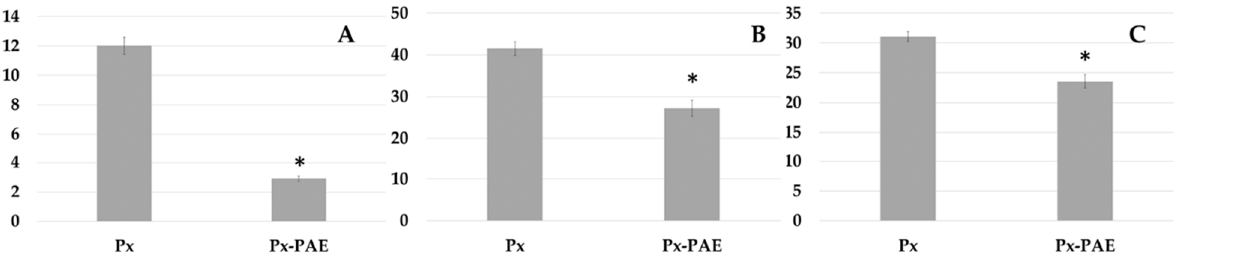
Figure 9. Control of P. xanthii by spraying zucchini plants with P. variotii . ( A ). Mean proportion of leaf area with powdery mildew symptoms per plant. ( B ). Percentage of the number of leaves with symptoms per plant. ( C ). Percentage of number of petioles with powdery mildew. Px: Application of P. xanthii . Px ‐ PAE: Application of P. variotii three days before application of P. xanthii . Means with * denote significant difference between both treatments according a pairwise comparison using Student’s t ‐ test ( p < 0.05).